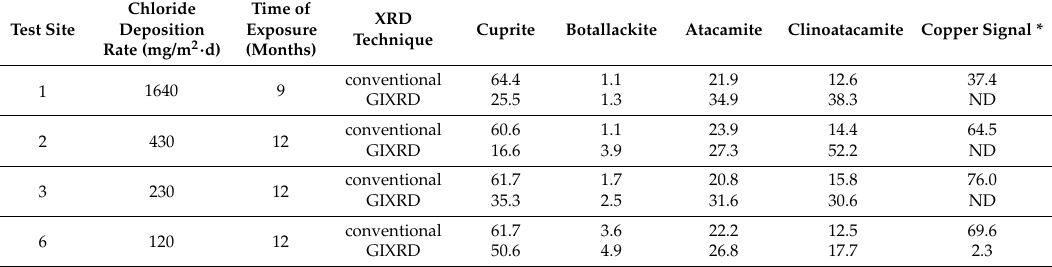
Table 7. Quantification (wt %) of the different phases formed on copper by conventional XRD and